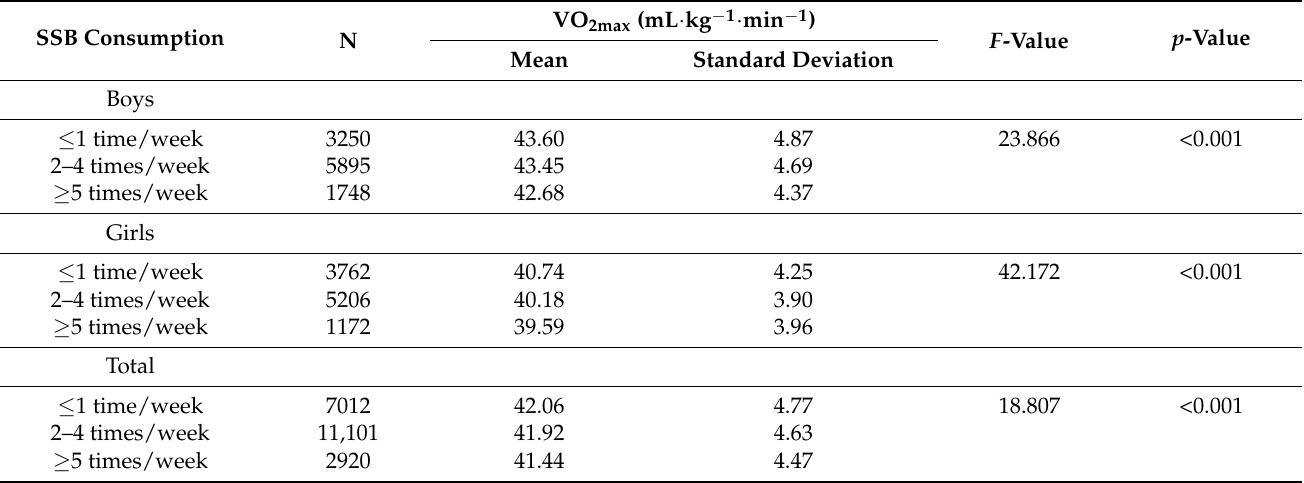
Table 3. VO 2max status of children in China with different consumption of